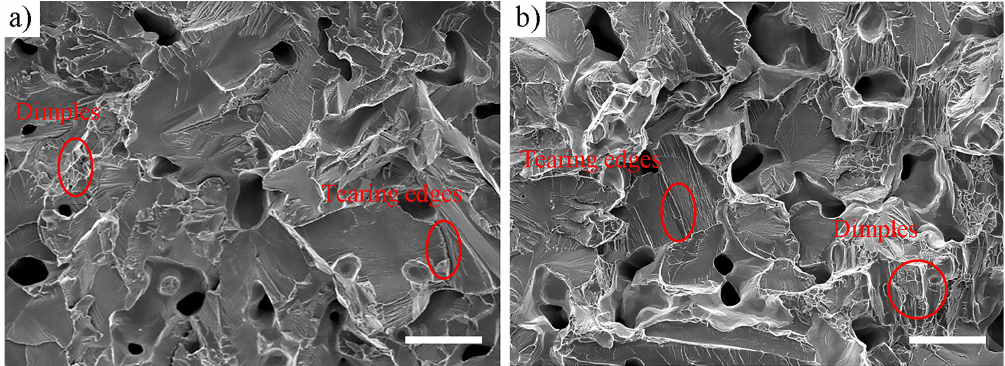
Figure 15. SEM micrographs of the fracture surface of BJ3DP Ti6Al4V samples sintered with pure powder ( a ) and mixed powder ( b ). Scale bar = 50 µ